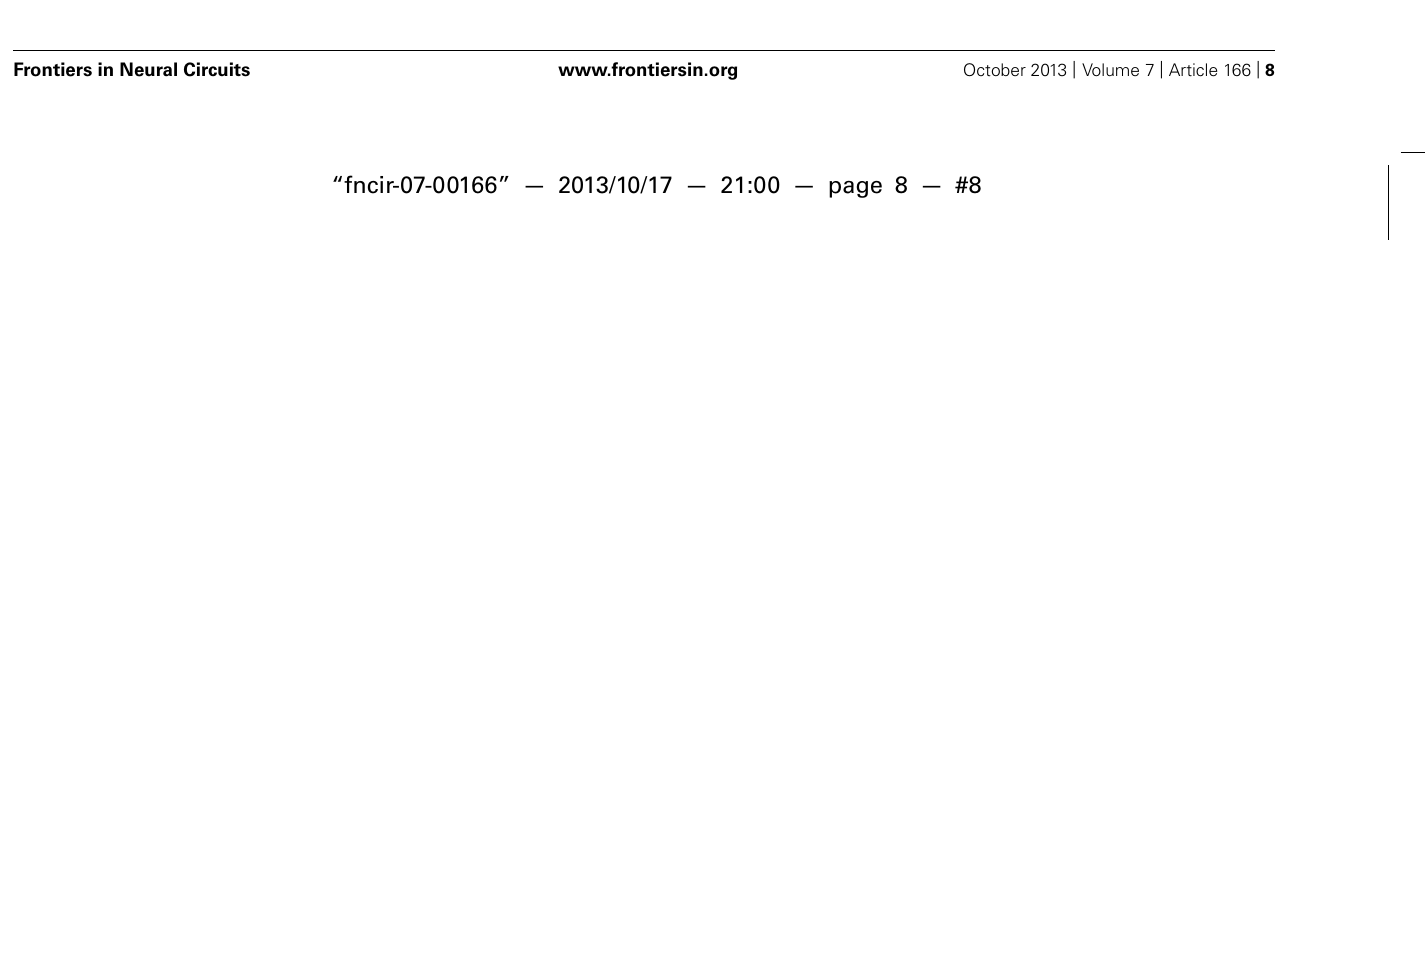
areas correspond to the DRNL outputs.The best frequency and the peak correlation value for each recording site are labeled on the top-right of each